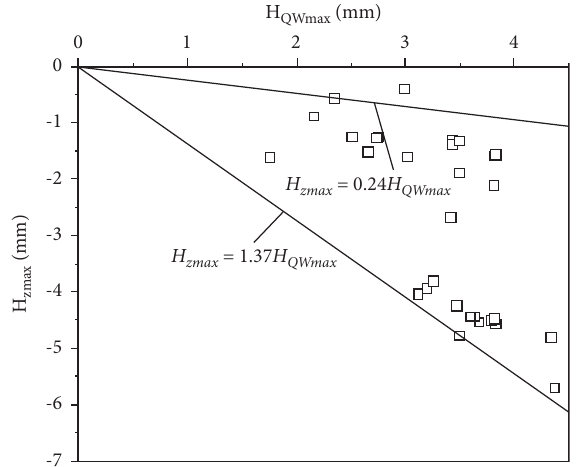
Figure 19: The change of steel support axial force with excavation depth.